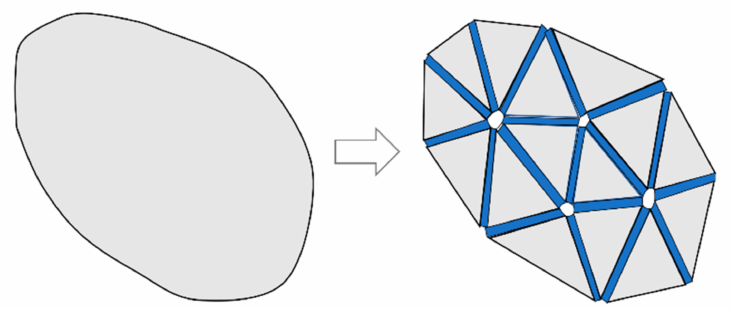
Figure 1. The connection relationship between the triangular element and joint element in FDEM